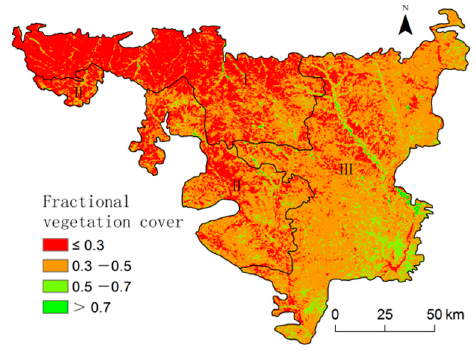
Figure 4. Variations in FVC in the Pisha Sandstone area from 2000 to 2019.